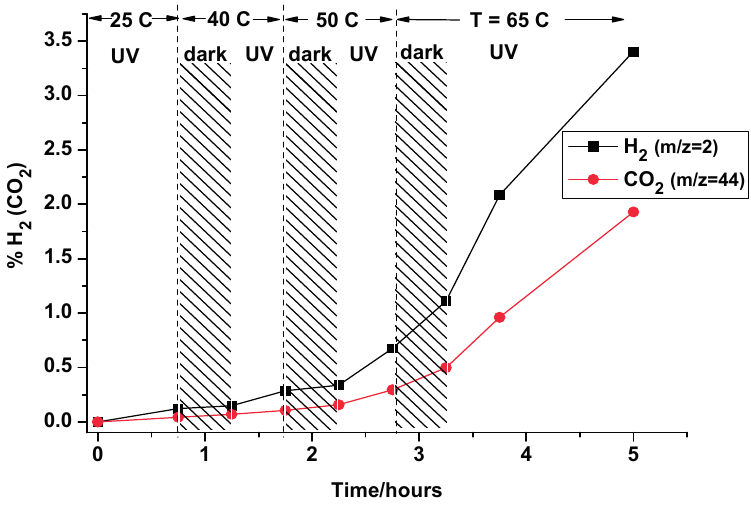
Figure 22. MS response (H 2 /CO 2 ) showing effect of temperature on rate of vapour-phase CH 3 OH photoreforming over Pt/TiO 2 (reproduced from [288] with permission of RSC).